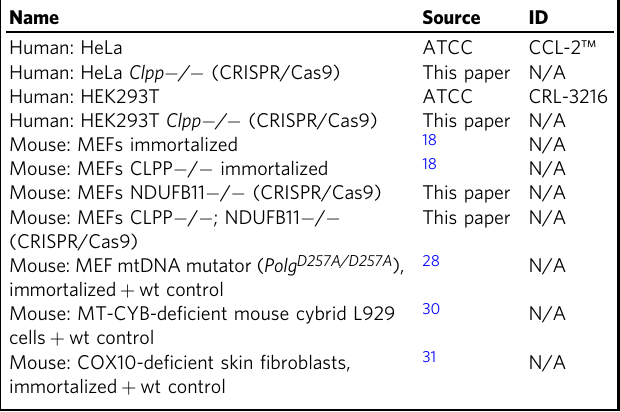
Fig. 6 Loss of CLPXP ameliorates respiratory chain de fi ciency caused by OXPHOS complex instability. a BN-PAGE followed by western blot analysis of CI in wild type (WT) and PolgA mut /PolgA mut (mtDNA mutator) MEFs upon the 48 h siRNA-mediated Clpx knockdown. SDHA and VDAC were used as a loading control ( n = 2, biologically independent experiments). b Proliferation capacity of mtDNA mutator MEFs upon siRNA-mediated Clpx